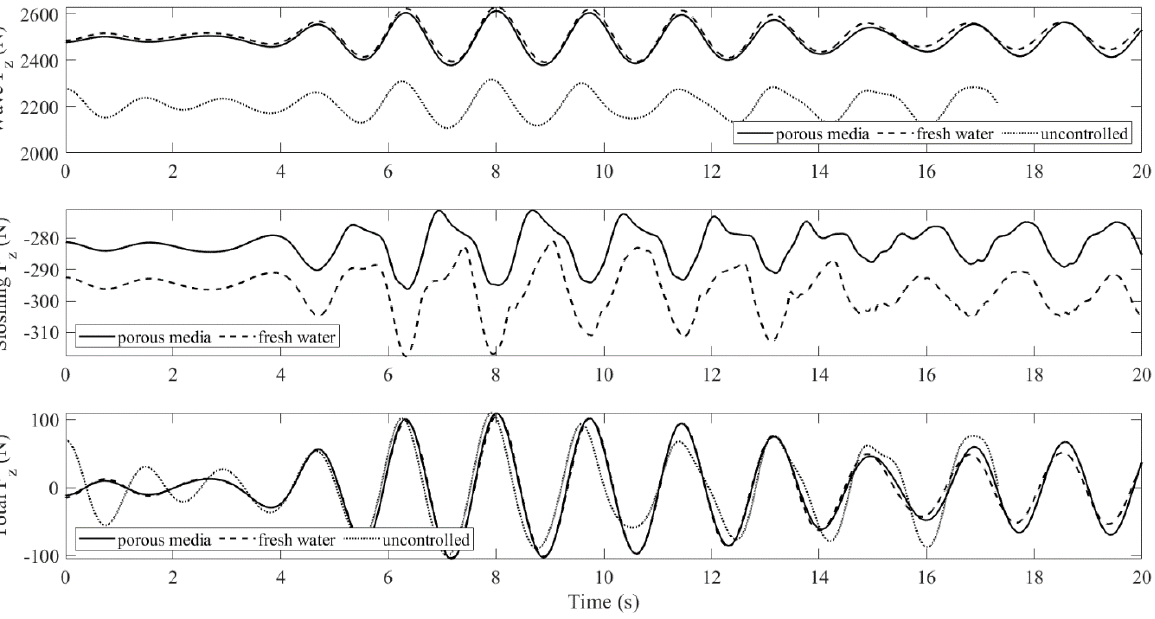
Figure 26. The vertical forces act on the controlled and uncontrolled floating bodies for the large- wave case.